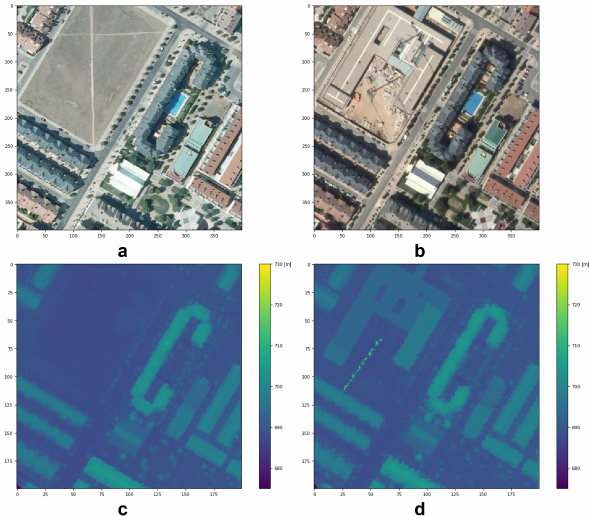
Thus, for each pair of optical images, two CD maps were pro- duced, focusing on the changes affecting only artificial manu- facts (i.e. buildings, Figure 4). The first one is the 2D CD map, in which we annotated the pixels belonging to areas where a change in elevation occurred. These maps were constructed using the software QGis (QGIS, 2022a), taking the 400 × 400 orthophotos as reference and comparing them with the DSMs difference maps. Then, pixels belonging to the areas affected by a change in elevation over the years were delineated. In par- ticular, two classes were identified: (i) no change; (ii) changes due to construction (positive elevation change) or demolition (negative elevation change) of artefacts/buildings. The 2D CD maps are characterised by the same resolution (400 × 400 pixels) of the orthophotos from which they derive, with a GSD of 0.50 m (Figure 5). The second CD map is the 3D CD map (Figure 4), obtained from the difference between the DSMs as aforementioned, with a resolution of 200 × 200 pixels and a GSD of 1